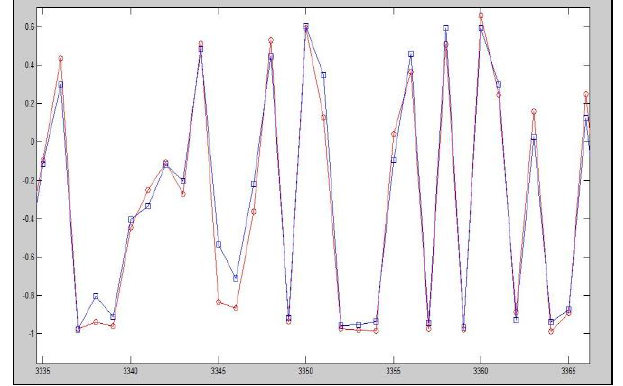
Figure 9. Results of the neural network for the training data The mean square error for the test data which is not used for constructing the network is 0.0345. The results for the test data is presented in Figure 10. In this figure, the red cycles are the test data and the blue squares are the output test data of the neural